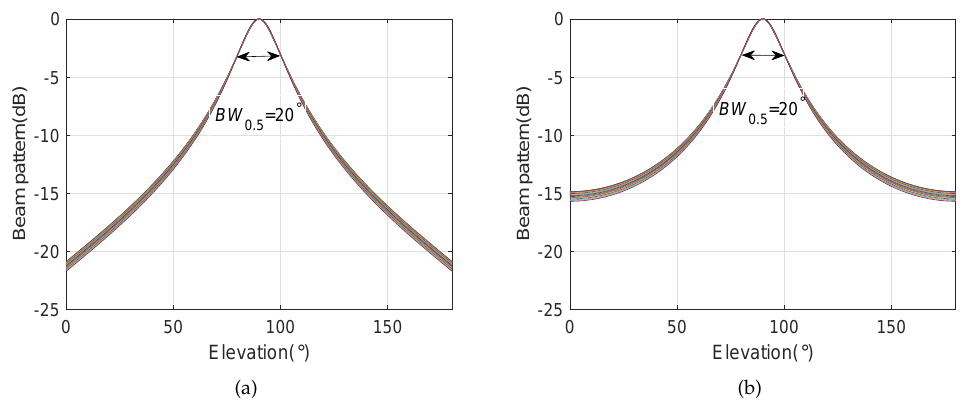
Figure 11. Beampatterns of the coupling magnified array in the elevation plane, where the beampattern is steered at φ s = 90 ◦ and the azimuth angle is fixed at θ = 130 ◦ . ( a ) BCAVSA; ( b ) bi-cone pressure sensor array.